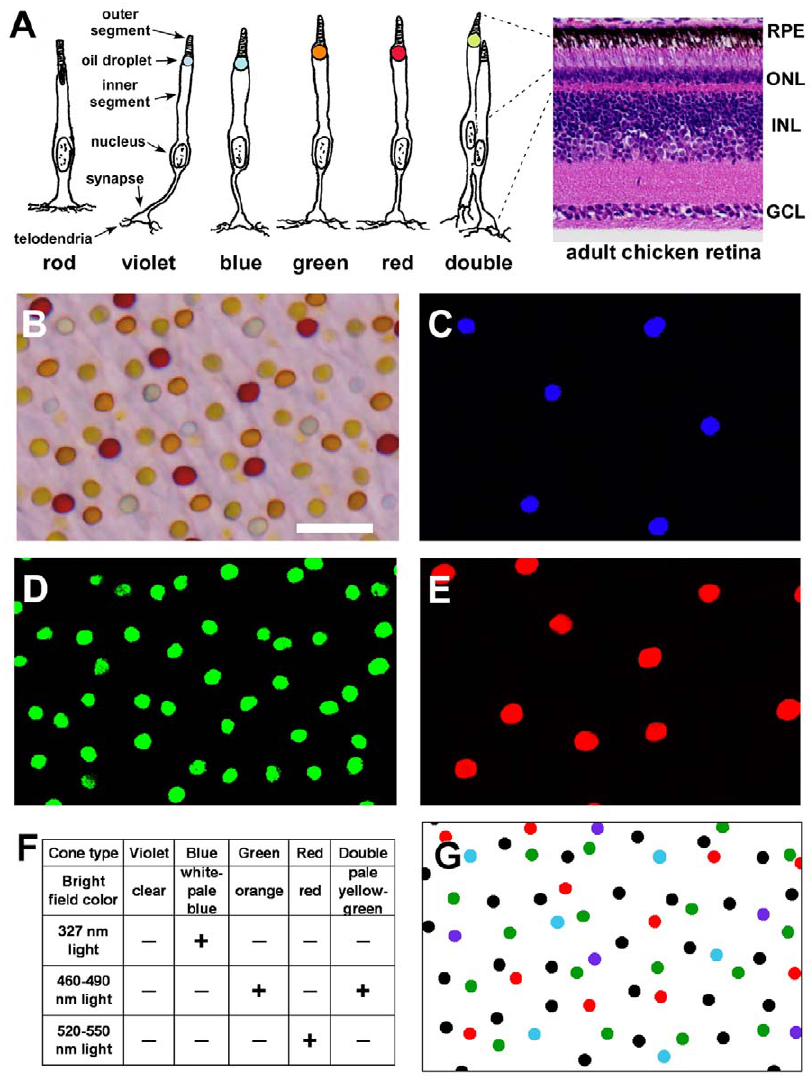
Figure 1. Oil droplets permit classification of chicken cone photoreceptors. (A) Diagram of the seven photoreceptor cell types of the chicken retina. Oil droplets are colored approximately according to their appearance under brightfield illumination. Rods and the accessory member of double cones lack oil droplets. A hematoxylin and eosin-stained section of an adult chicken retina is shown on the right. The drawing are based on depictions of avian rods and cones by Ramo´n y Cajal [73]. RPE, retinal pigment epithelium; ONL, outer nuclear layer; INL, inner nuclear layer; GCL, ganglion cell layer. (B) Brightfield view of a flatmounted P15 chicken retina viewed photoreceptor side up. Size bar=10 m m. (C–E) Same field as in (B) viewed under ultraviolet (327 nm) light (in C), blue (460–490 nm) light (in D) and green (520–550 nm) light (in E). Only blue cones show fluorescence under ultraviolet light, and this fluorescence is short-lived. Both green cones and double cones fluoresce under blue light. Only red cones fluoresce under green light. (F) Table summarizing the appearance of chicken oil droplets under brightfield and fluorescent light. (G) Digitized versions of the field shown in (B). Colored dots correspond to their respective single cone types. Black dots represent double cones.